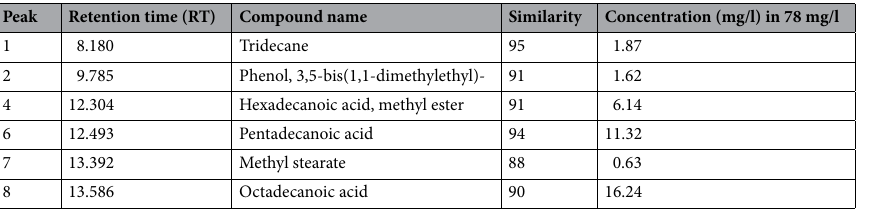
Table 10. Compound profile of Globitermes sulphureus defense fluid determined by GC–MS, with retention time, similarity, concentration and compound